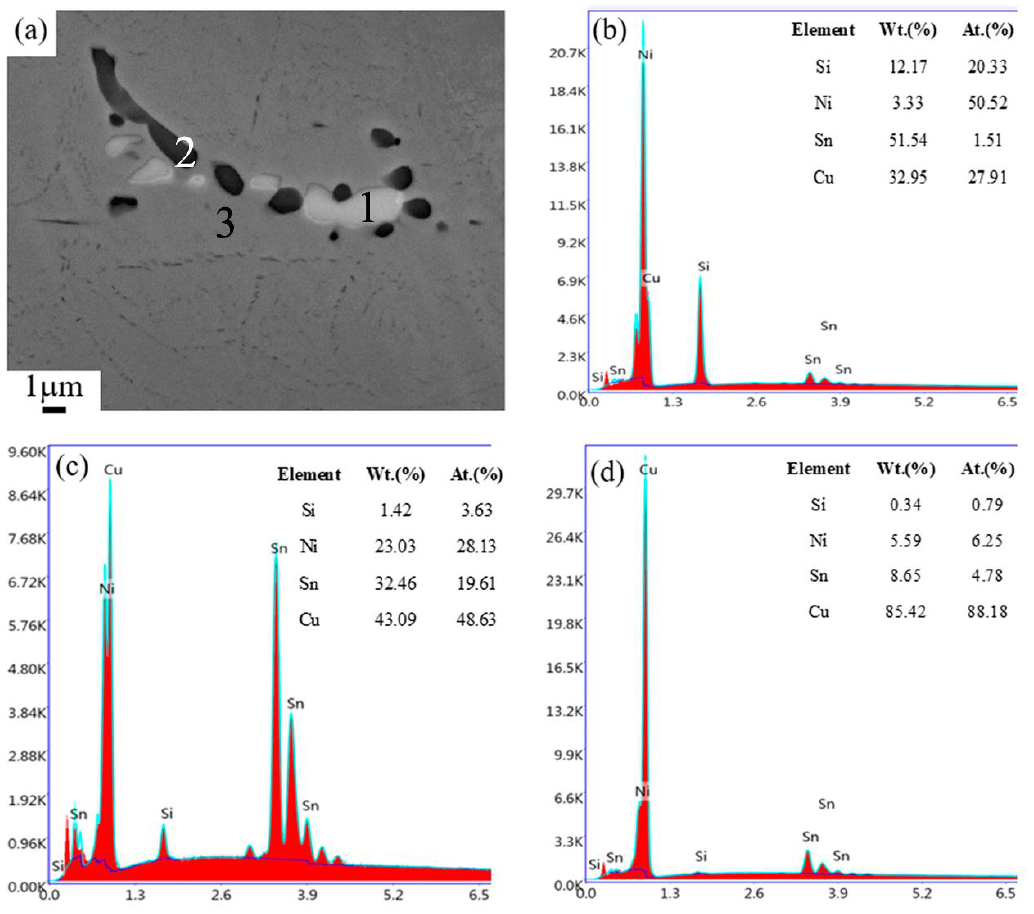
Figure 4. The SEM images ( a ) and EDS results of the as-cast sample of the Cu–6Ni–6Sn–0.6Si alloy: ( b ) point 1, ( c ) point 2, ( d ) point 3.